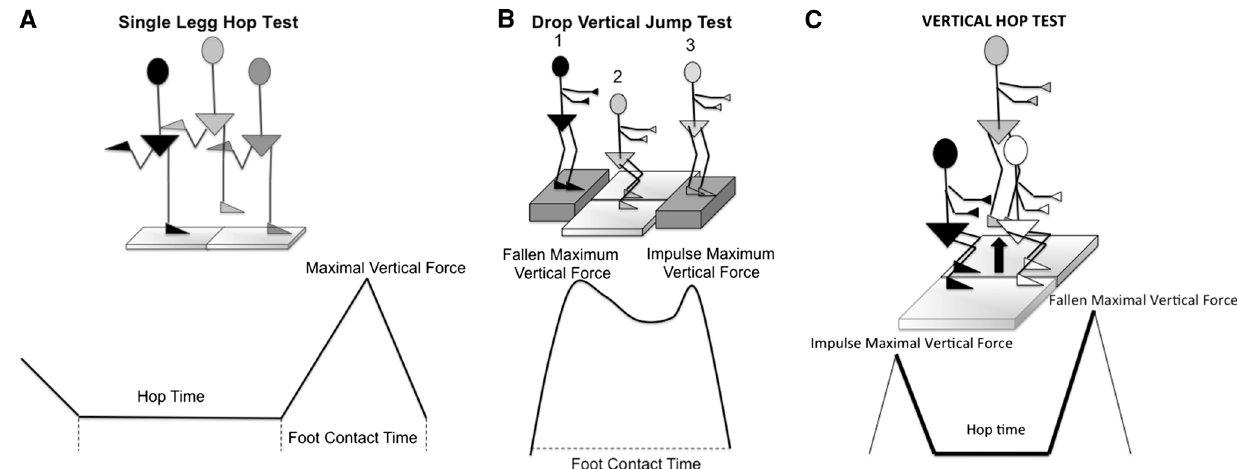
Fig. 2 a Single-leg hop test and kinetics graph. The single-leg hop test for distance was performed as previously described [18]. Patients were instructed to stand on one leg and to position their toes against a mark on the floor. They were then instructed to hop forward as far as possible and to land on the same leg. b Drop vertical jump and kinetics graph. Subjects were instructed to drop off a 30-cm box and